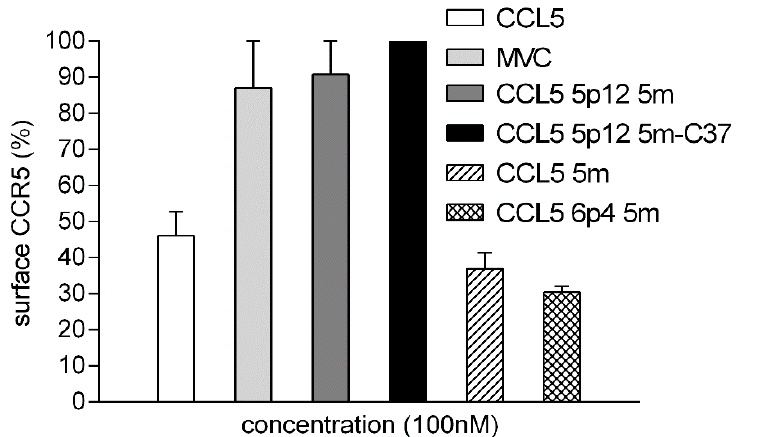
Figure 2. CCR5 internalization by CCL5 variants and MVC. Cytofluorimetry of CHO-CD4-CCR5 cells labeled with the anti-CCR5 mAb 3A9. Cell surface CCR5 was set at 100% for cells treated with